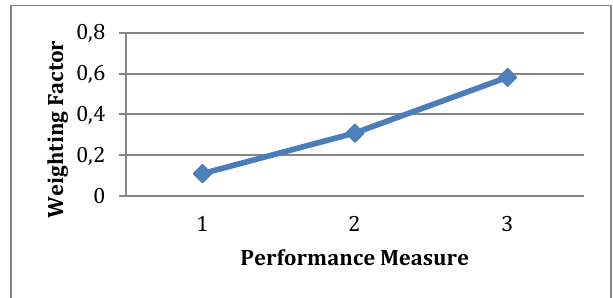
Figure 23: Remanufacturing sustainability assessing measures